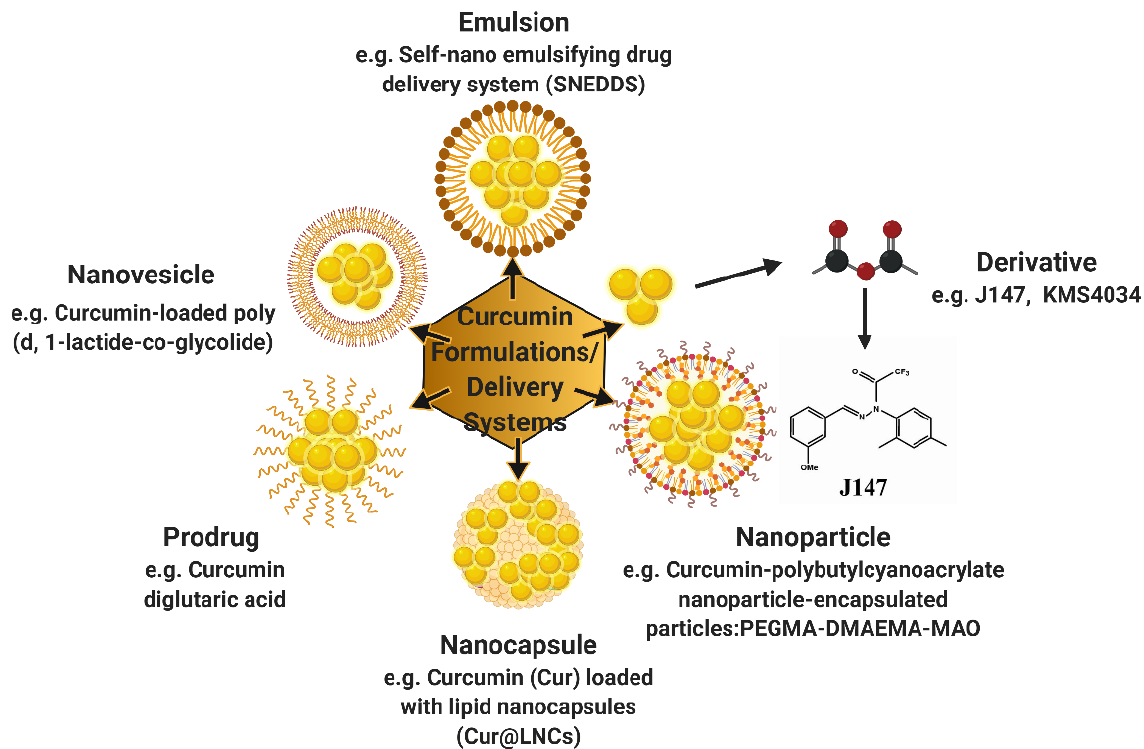
Figure 3. Schematic representations of different curcumin formulations and delivery systems along with their respective examples discussed in the review (created with BioRender).